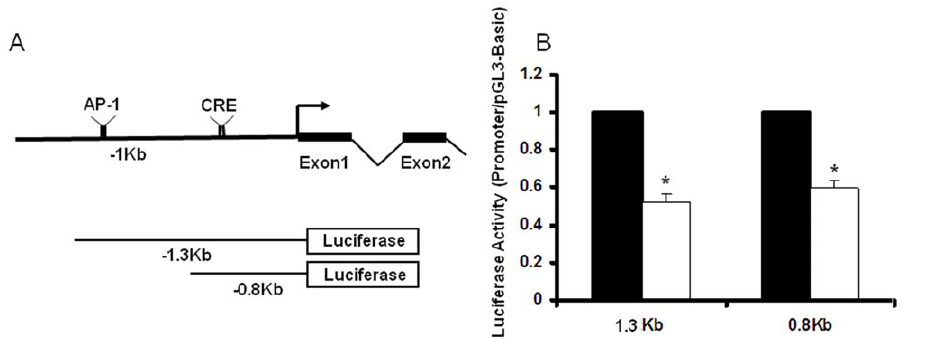
Figure 9. Invitro methylation inhibits promoter activities. A. The structure of the luciferase reporter gene constructs of the NR2B gene promoter, containing CREB (0.8 kb) or both CREB and AP-1 (1.3 kb) binding sites. B . Constructs 1.3 and 0.8 kb were in vitro mock-methylated and methylated and transfected into cultured cortical neurons. Cells were collected 48 h after transfection. Solid and open bars represent the luciferase activities from mock-methylated and methylated promoter, respectively. Data (mean 6 SEM) shown are from at least three independent experiments. *, p , 0.05 compared to the mock-methylated control constructs.